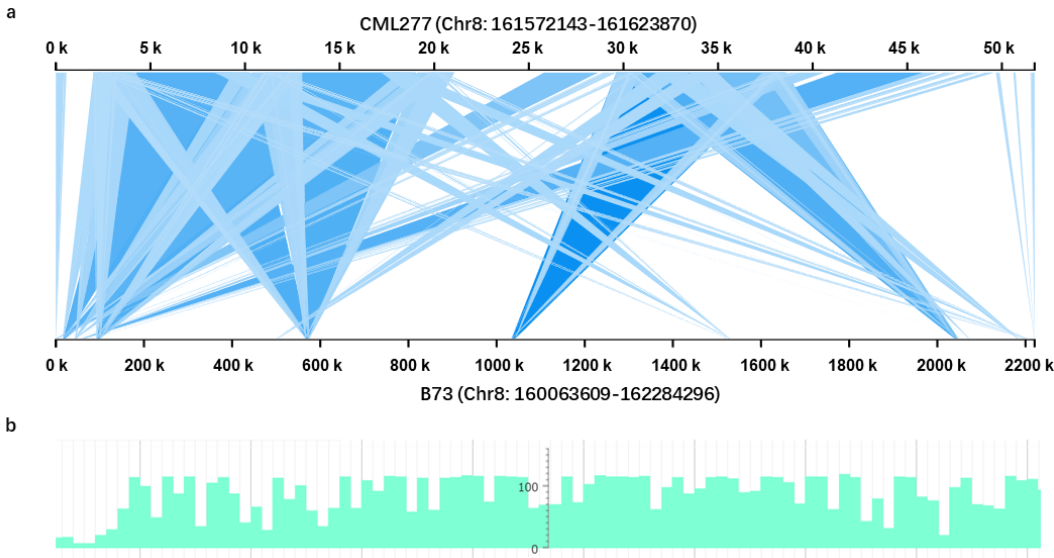
Figure 3. Sequence comparison between B73 and CML277 in the ZmGHT1 locus. ( a ) Illustration of the SVs between B73 and CML277 in the ZmGHT1 locus. ( b ) Distribution of the TEs in the ZmGHT1 locus based on B73 genome sequence information.